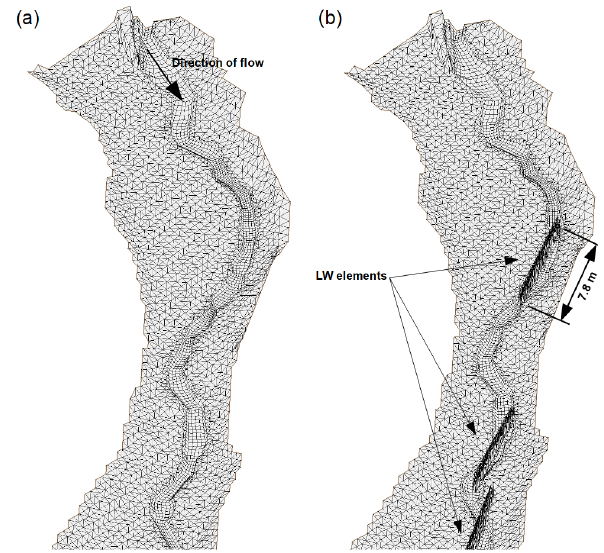
Figure 4. (a) Calculation mesh of the hydrodynamic model used in simulation variants RV, V1 and V2 with the use of variable Strickler coefficients adjusted for the entire channel (V1) or adjusted at the positions of all LW elements only (V2); (b) mesh with discrete LW elements used in variant V3. Example of the first 60m of the study